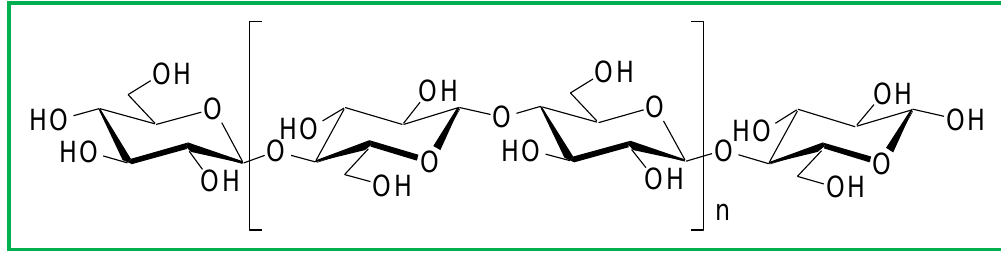
Figure 1. Basic chemical structure of cellulose showing the cellobiose repeat